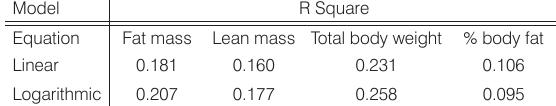
Table 2. Correlation coefficients (R-square) from curve estimation analyses with lumbar spine BMD as the dependent variable and body weight,% body fat, fat and lean mass, as the independent variables.